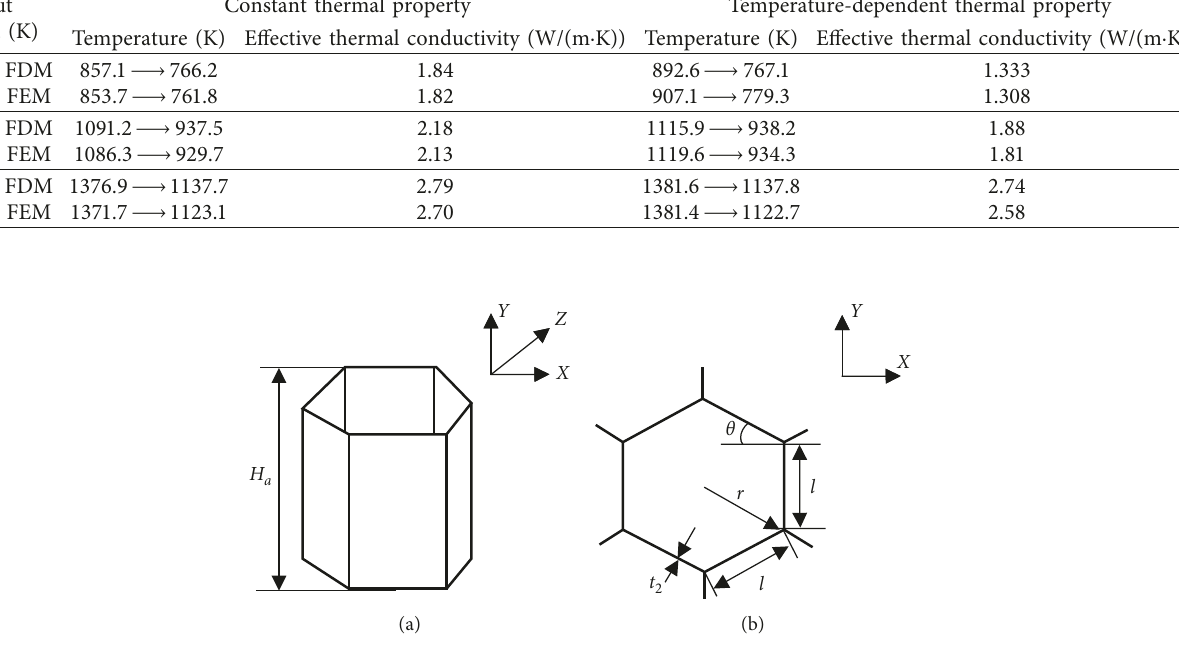
Figure 7: Geometry for honeycomb core. (a) Honeycomb core. (b) Honeycomb core section. Table 5: Natural frequency of the honeycomb sandwich Table 4: Materials for the honeycomb sandwich panel.